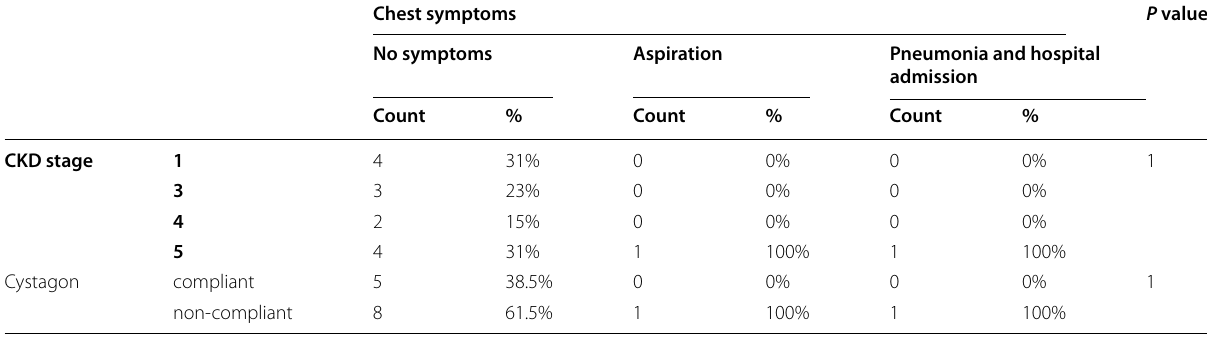
Table 2 Relation between chest symptoms and CKD stage and Cystagon